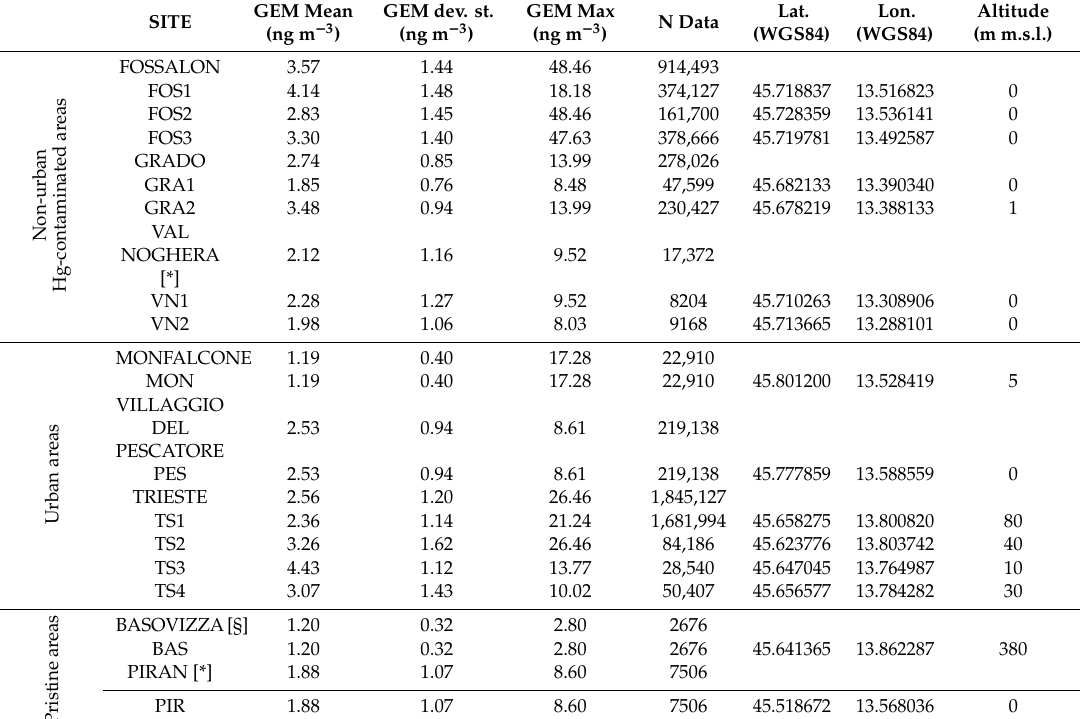
Table 1. Basic statistics of gaseous elemental mercury (GEM) dataset calculated on raw data (not resampled) and grouped by location. (*) Data published by [52] and (§) [51]. Lat. Lon. Altitude GEM Mean GEM dev. st. GEM Max N Data SITE (WGS84) (WGS84) (m (ng m − 3 ) (ng m − 3 ) (ng m − 3 )